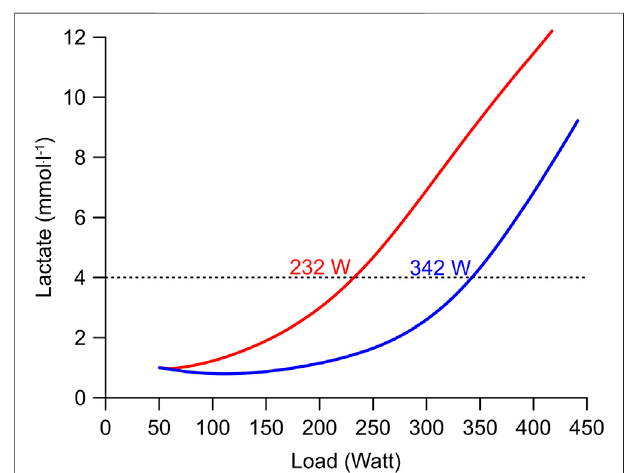
FIGURE 5 | Simulation of a graded exercise test of two subjects with extreme differences of their ν La.max but equal _ VO 2max (65 ml min − 1 kg − 1 ). The lactate curves are simulated using the revised version of Mader ’ s human exercise metabolism model (Mader, 1984; Mader, 2003). The fi rst subject (blue curve) has a low maximal glycolytic rate ( ν La.max ) of 0.3 mmol . L − 1 s − 1 . The second subject (red curve) has a ν La.max